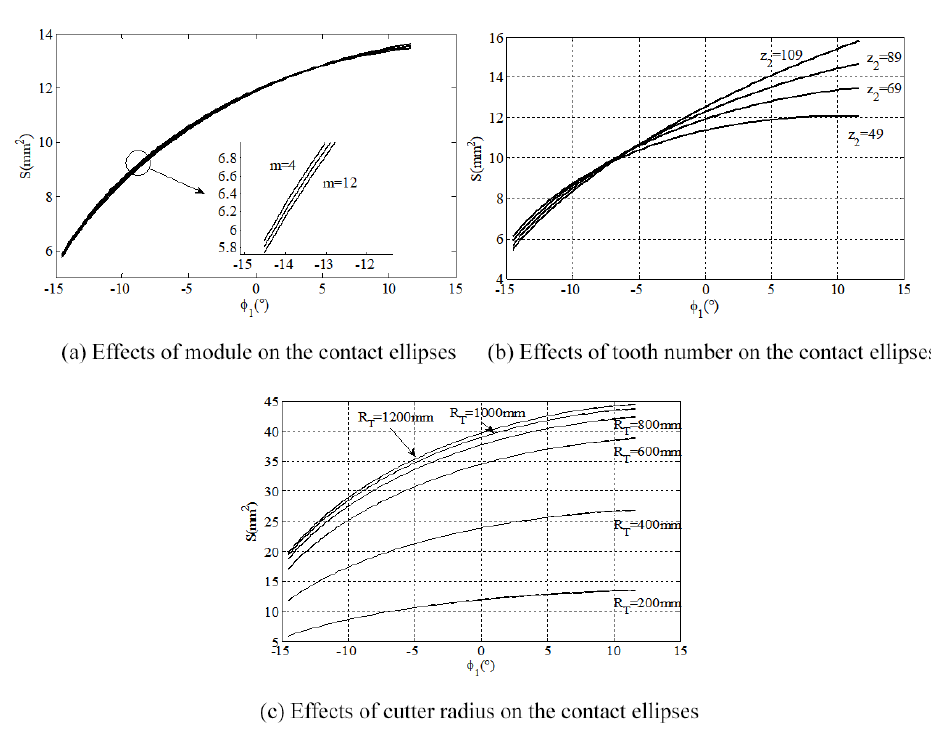
Figure 10. Effects of design parameters on the area of contact